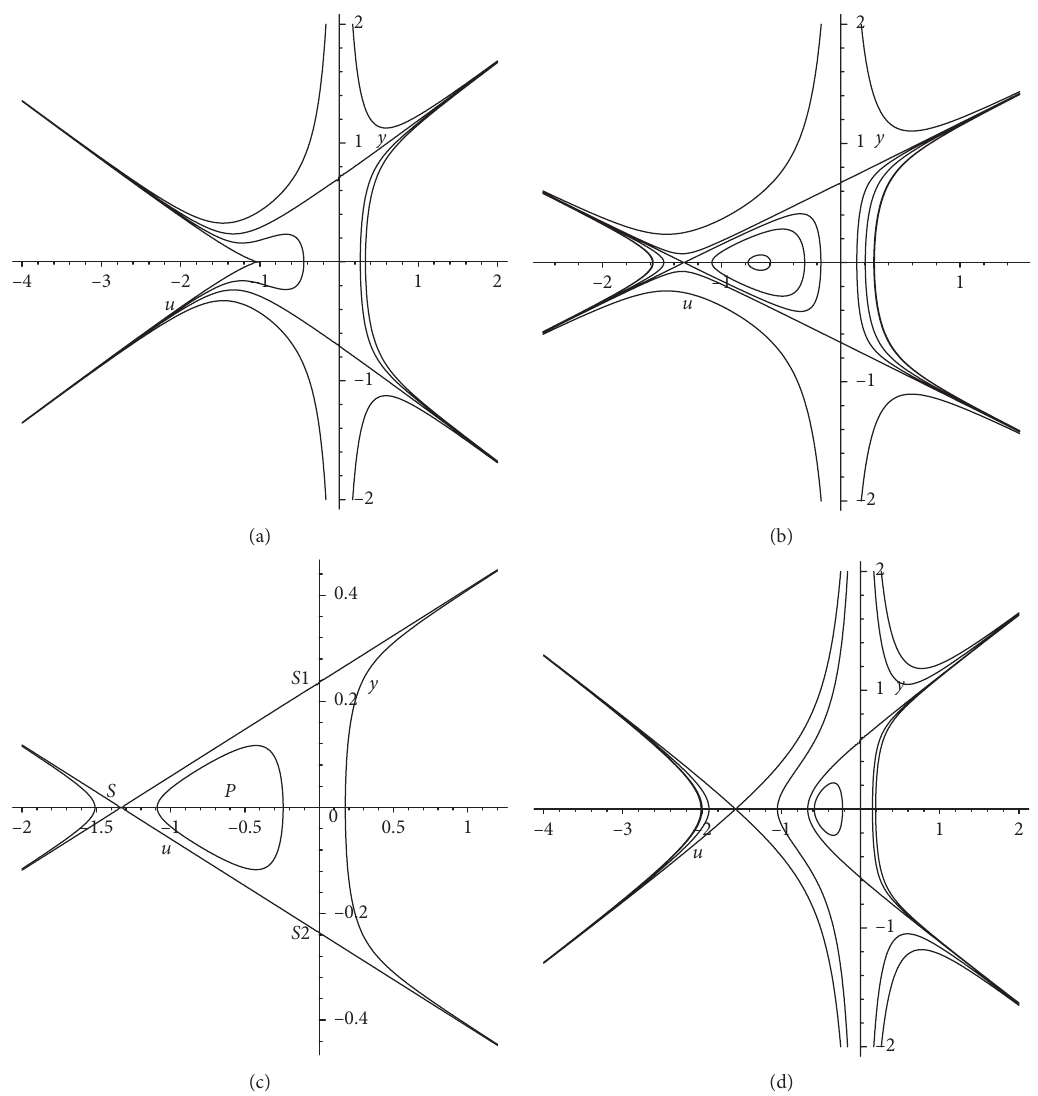
Figure 3: Phase portraits of system (9) when c > 0. (a) g � g